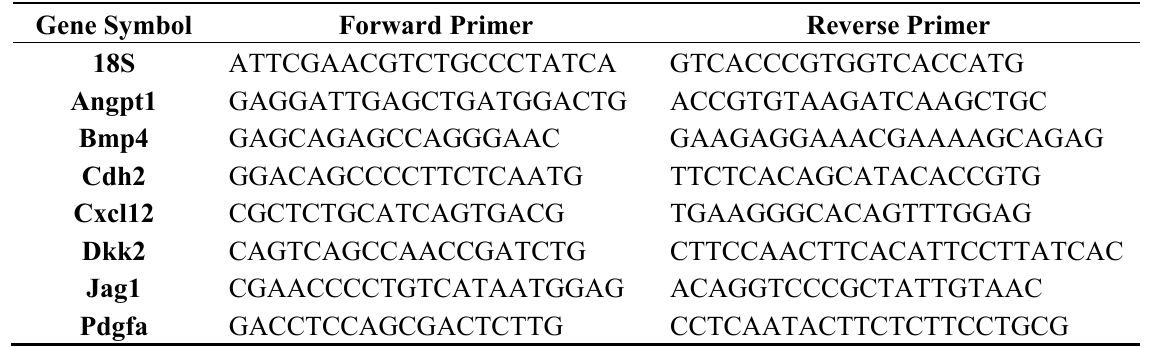
Table 1. Primer sequences used for reverse transcription (RT)-qPCR analysis of niche mediators. 18S rRNA was used as a loading control to normalize results. Abbreviations: Angiopoietin 1 (Angpt1); Bone morphogenic protein 4 (Bmp4); N -cadherin (Cdh2); Chemokine (C-X-C motif) ligand 12 (Cxcl12); Dikkopf 2 (Dkk2); Jagged 1 (Jag1); Platelet-derived growth factor alpha